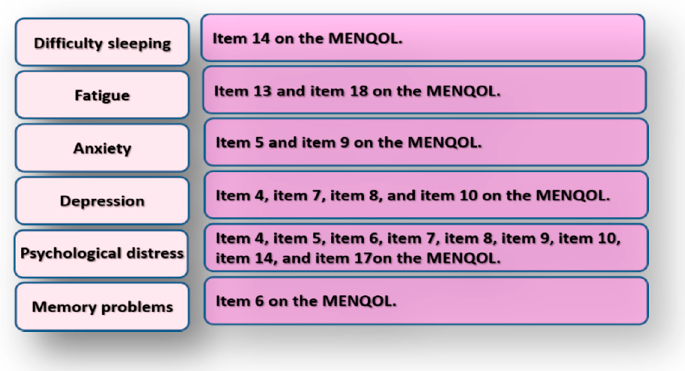
Figure 2. Definitions of key variables in this study. MENQOL: Menopause-Specific Quality of Life scale. Responses to items of the ATMS range from 1 to 4, and ATMS data were treated as numerical